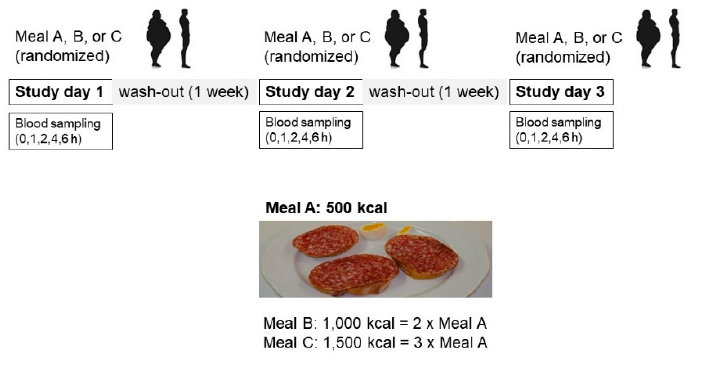
Figure 5. Design of the crossover study.